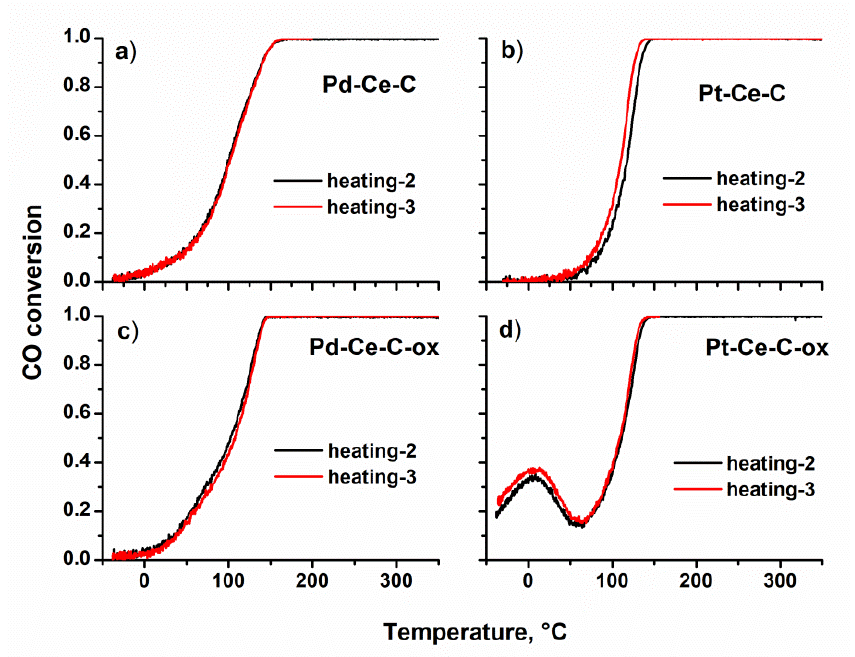
Figure A4. The temperature dependences of CO conversion during the second and third heating runs of the samples in the reaction mixture in the TPR-CO+O 2 mode. ( a ) Pd-Ce-C, ( b ) Pt-Ce-C, ( c ) Pd-Ce-C-ox, ( d ) Pt-Ce-C-ox catalysts.